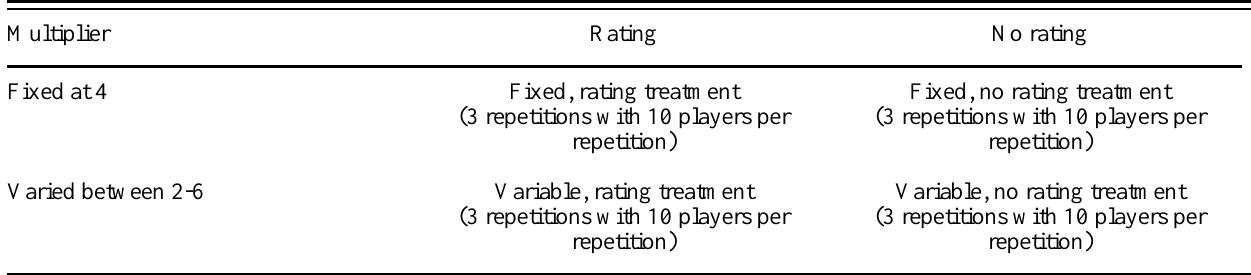
Fixed, no rating treatment (3 repetitions with 10 players per repetition) Variable, no rating treatment (3 repetitions with 10 players per repetition)